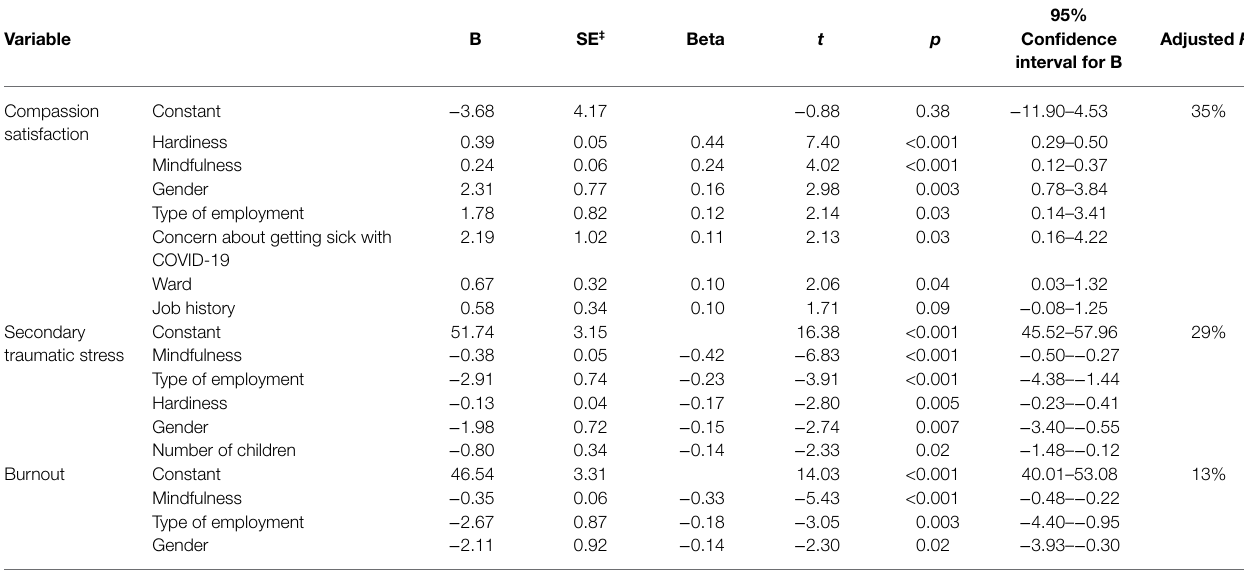
TABLE 4 | Multiple regression analysis summary for predictors of ProQol among nurse ( n = 239).